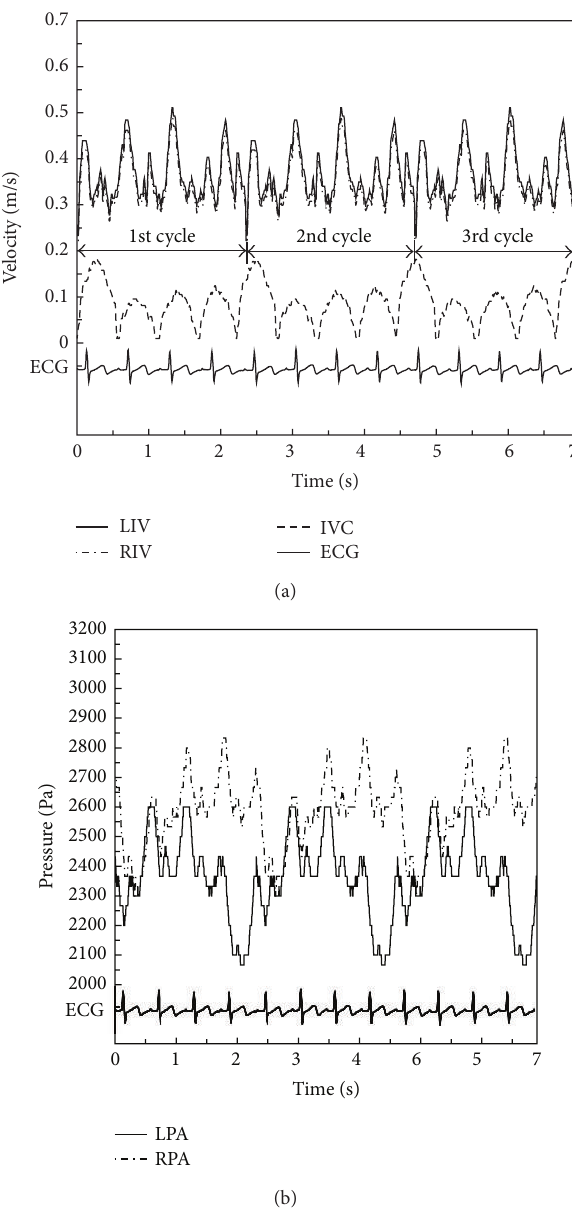
Figure 1: Clinical data as boundary conditions taking respiration into account. (a) Velocity data as inlet boundary conditions at the IVC, LIV, and RIV. (b) Pressure data as outlet boundary conditions at the LPA and RPA (IVC: inferior vena cava; LIV: left innominate vein; RIV: right innominate vein; LPA: left pulmonary artery; RPA: right pulmonary artery; ECG: